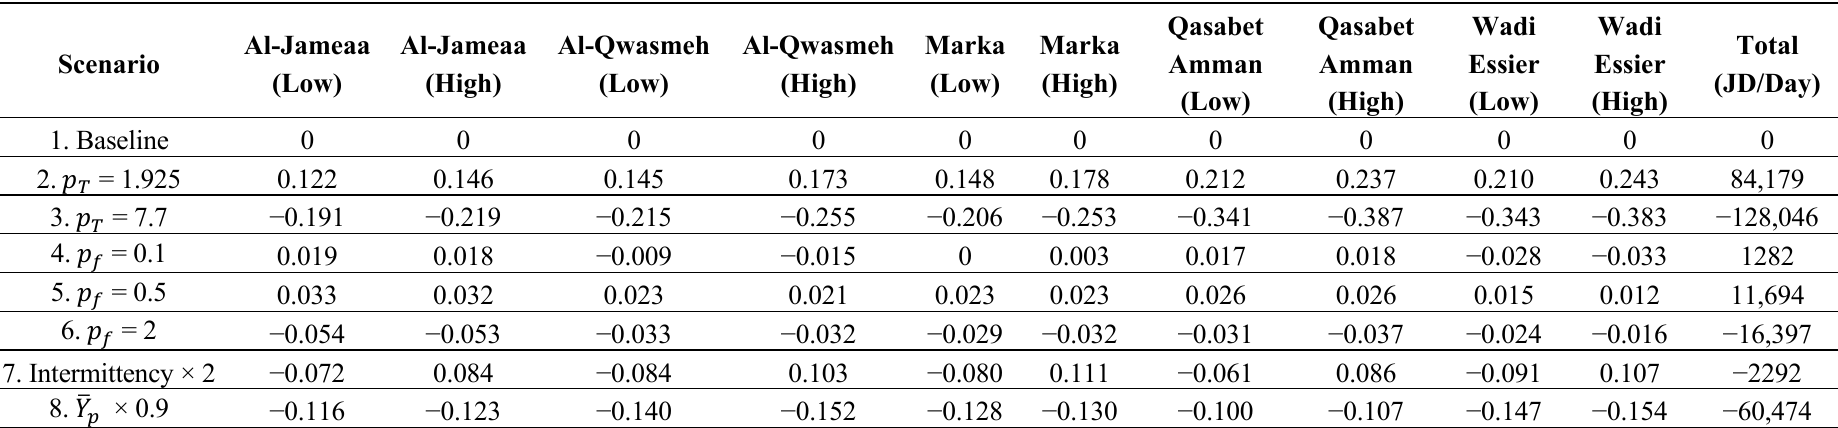
Table 4. Consumer surplus difference to baseline